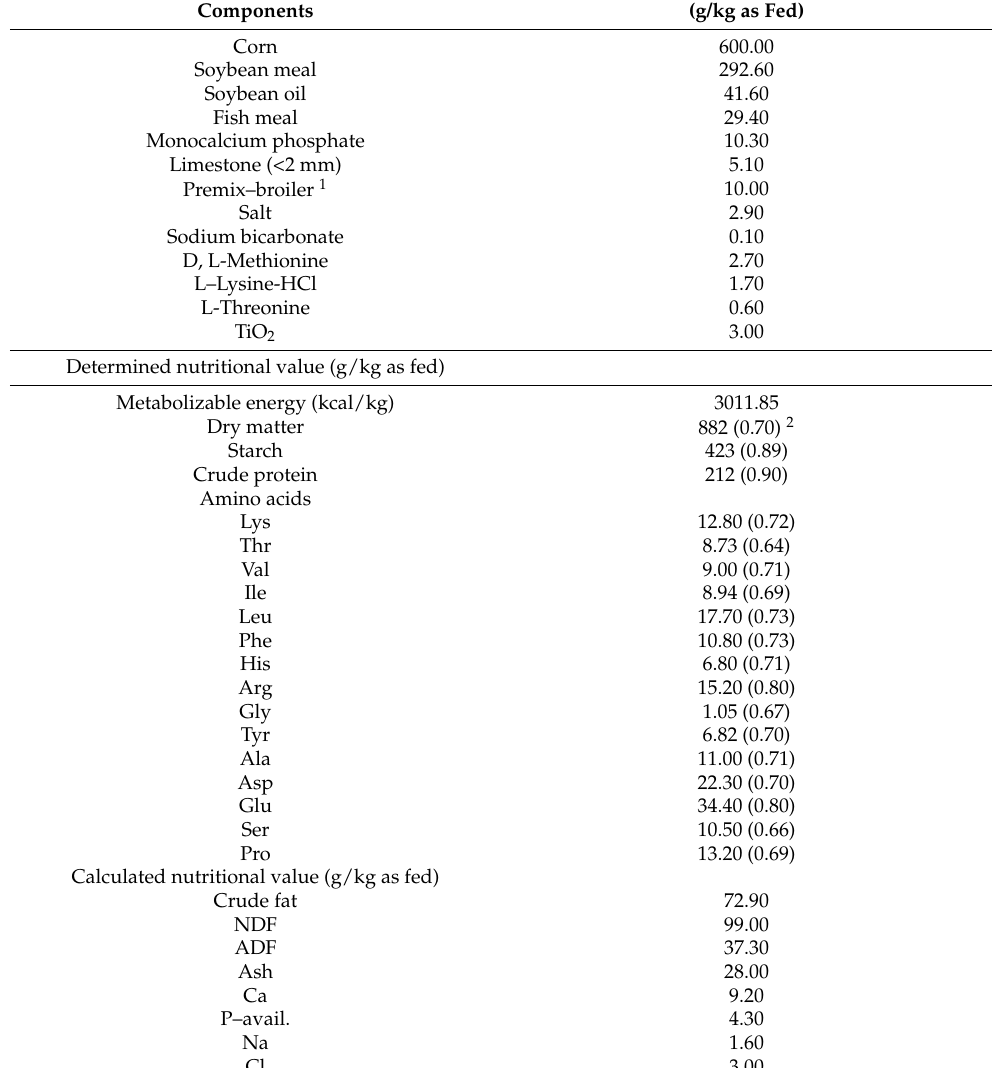
Table 2. The composition and nutritional value of reference